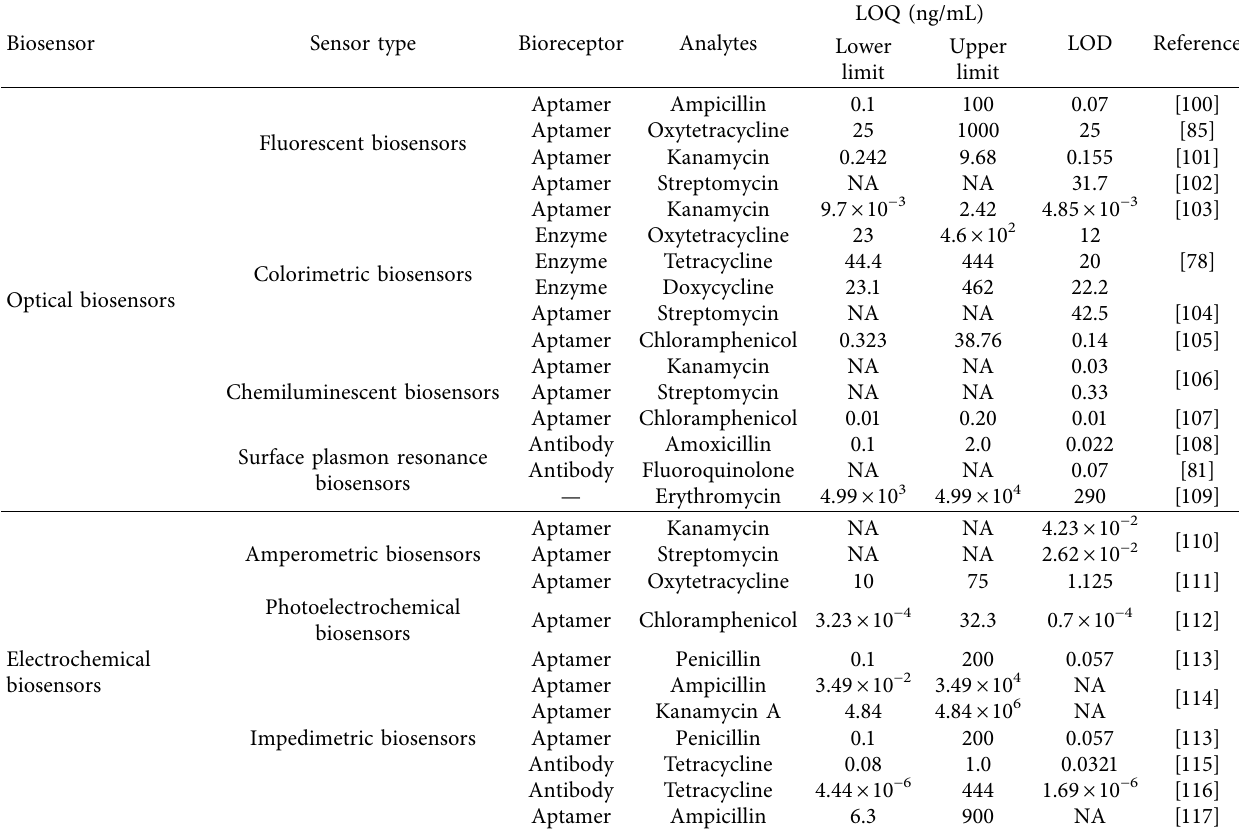
Table 3: Summary of optical/electrochemical biosensors for the detection of antibiotics.